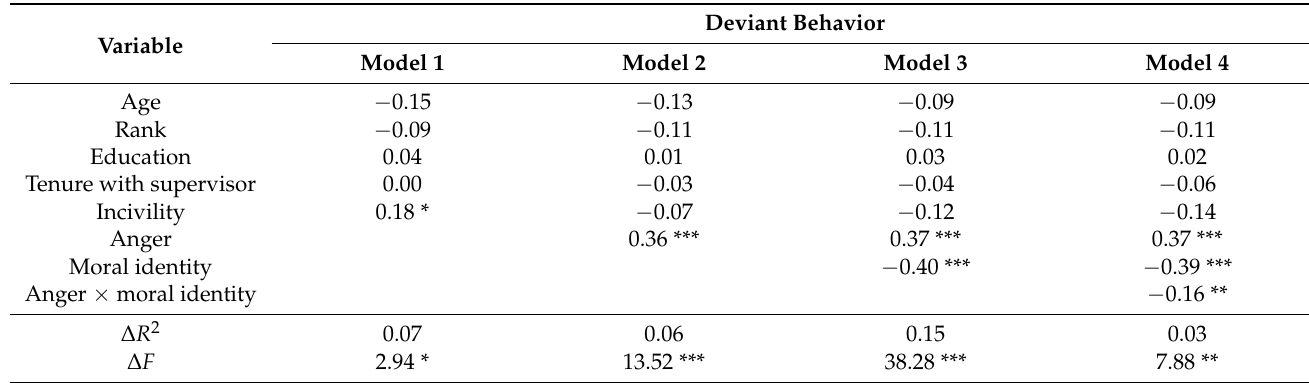
Table 4. Results of regression analyses.